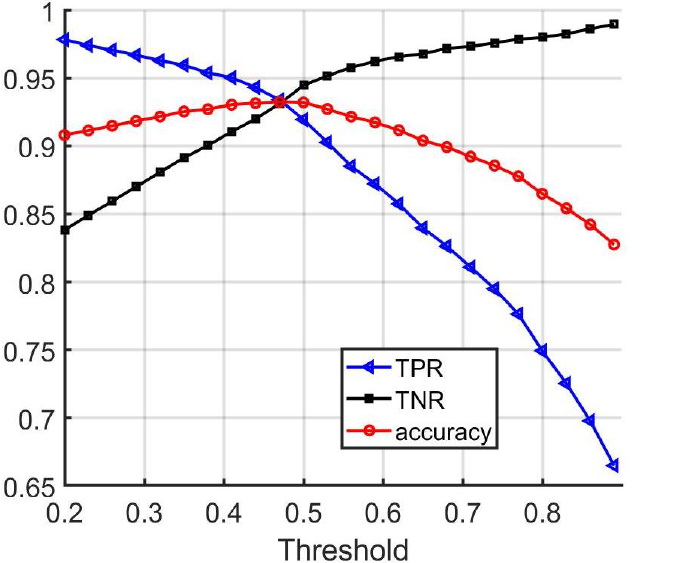
Figure 8. Performance of wheel matching